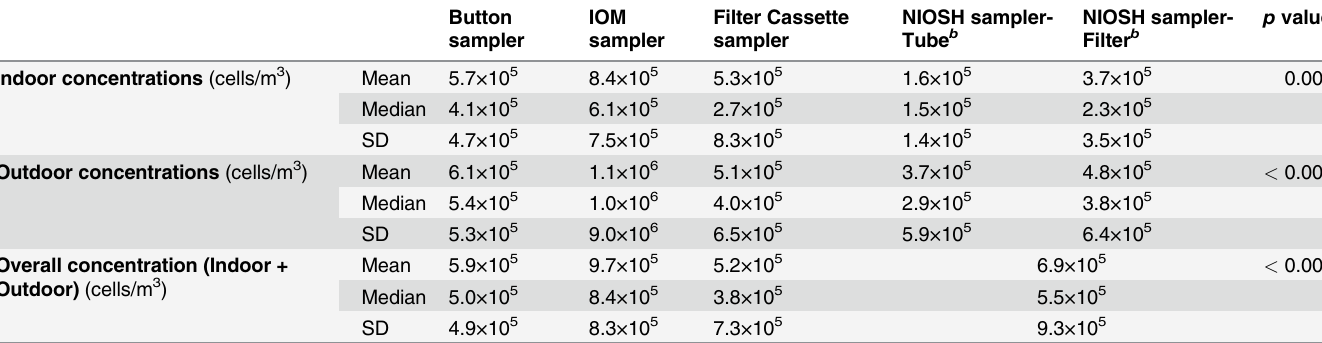
Table 5. Relative efficiency comparison of personal samplers based on total bacterial concentrations. a